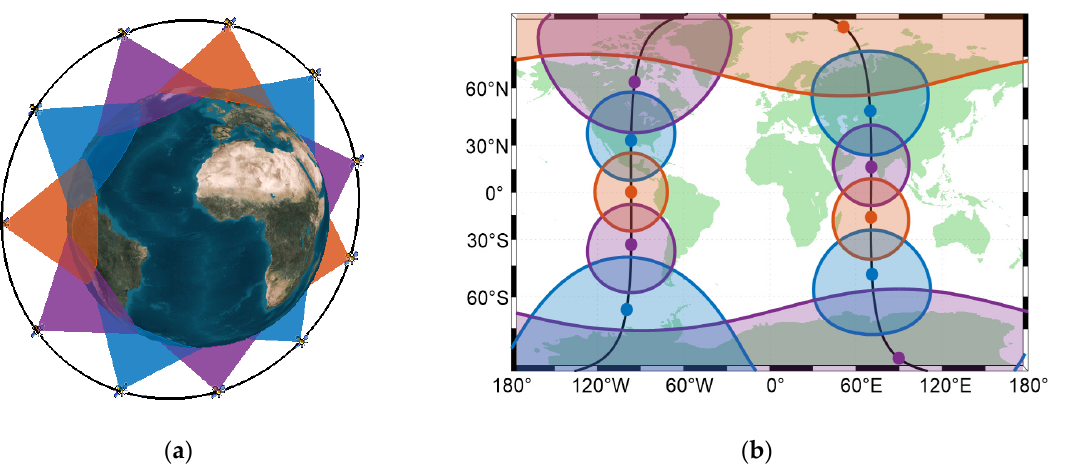
Figure 1. Satellite PRN code assignment diagram of a constellation composed of 11 satellites. Three colors represent three PRN codes, which are enough to realize CDMA for 11 satellites. ( a ) Three- dimensional view of the PRN code assignment; ( b ) Two-dimensional view of the PRN code assignment. The points are satellite positions. The circles are the range in which the satellite PRN codes can be received on the ground.